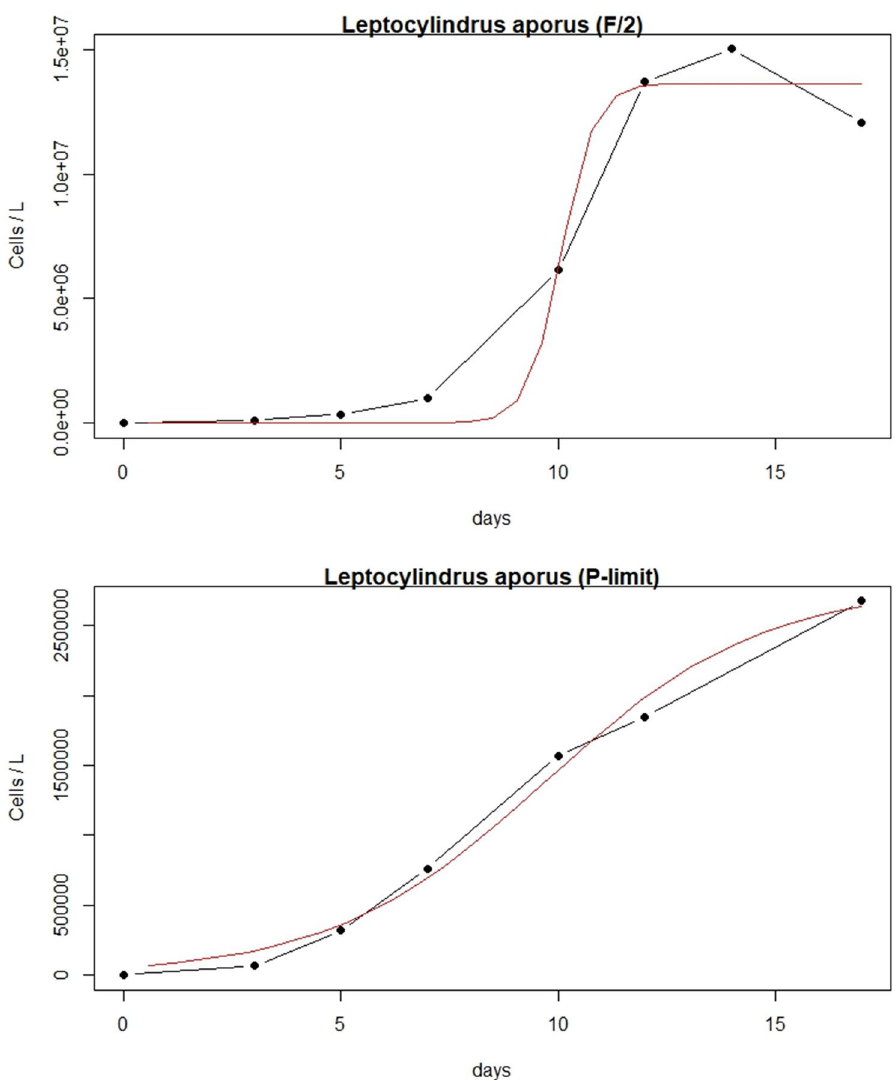
Figure 5. Growth curves of L. aporus : averaged cell concentrations in F/2 and P-limit medium throughout 17 days of experiment